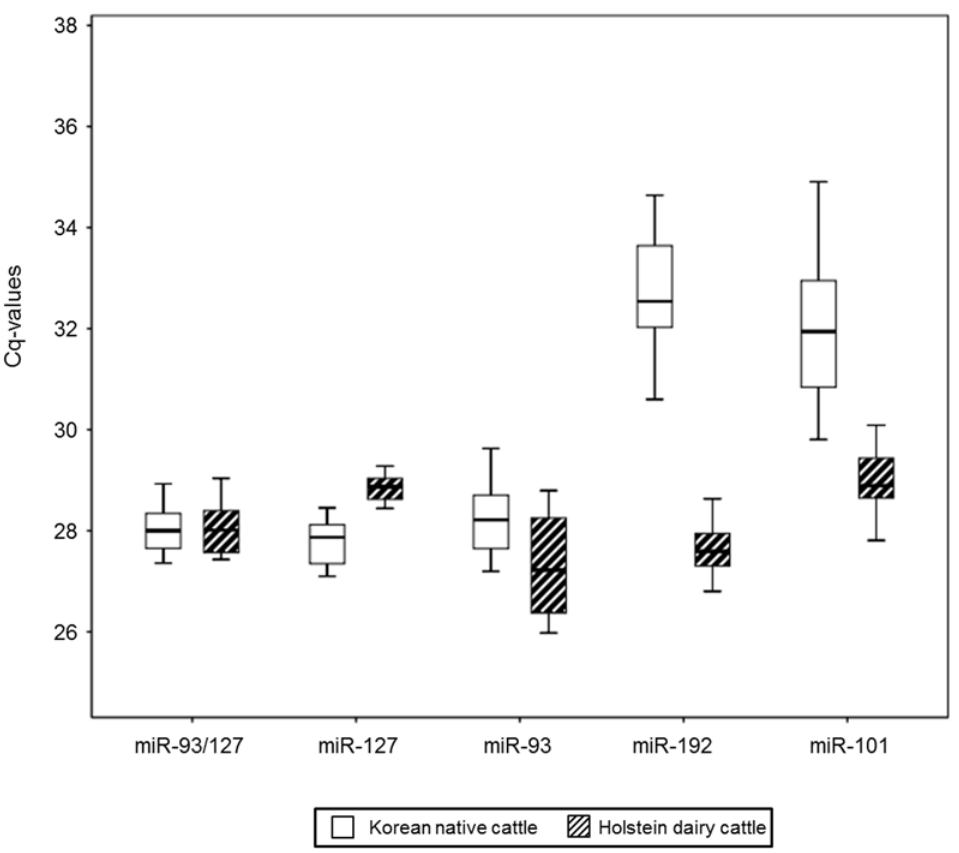
Fig 6. Expression levels of candidate reference miRNAs among different breeds. qRT-PCR analysis was conducted on bovine serum derived from Korean native cattle (n = 34) and Holstein dairy cattle (n = 16). Values are given as real-time PCR cycle threshold numbers (Cq values). Boxes (blank for Korean native cattle and diagonal lines for Holstein dairy cows) represent lower and upper quartiles with median.